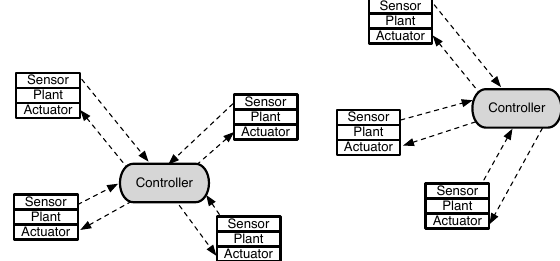
Figure 1. General structure of wireless networked control